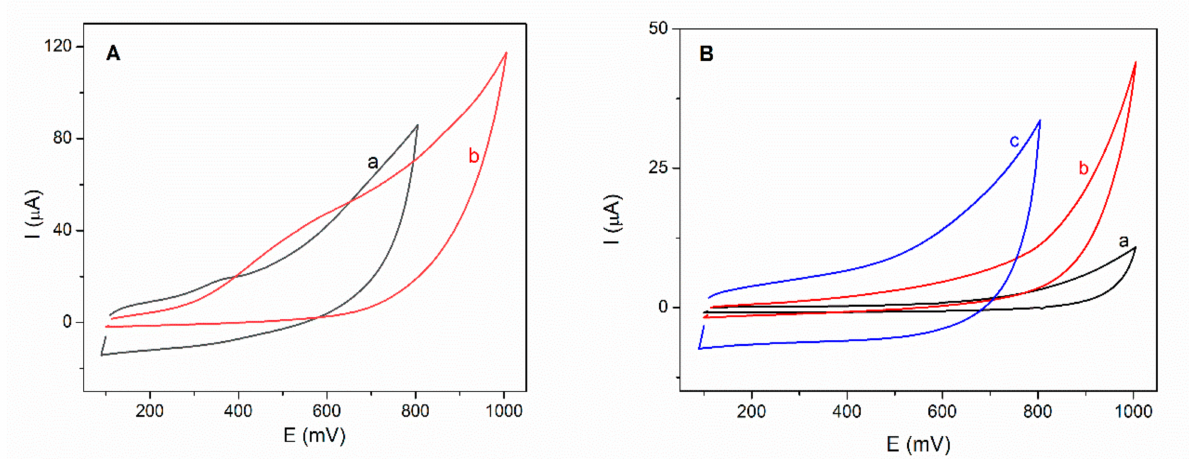
Figure 2. ( A ) Cyclic voltammograms recorded in 5 mM NADH for (a) LDH-AuNPs-ERGO-PAH/SPE and (b) GA- LDH/AuNPs-ERGO-PAH/SPE (SR = 100 mV/s, PBS pH = 7.5). ( B ) Cyclic voltammograms recorded on L-lactic acid 2 mM for (a) AuNPs-GO-PAH/SPE, (b) AuNPs-ERGO-PAH/SPE and (c) GA-LDH/AuNPs-ERGO-PAH/SPE (SR = 100 mV/s, PBS pH =